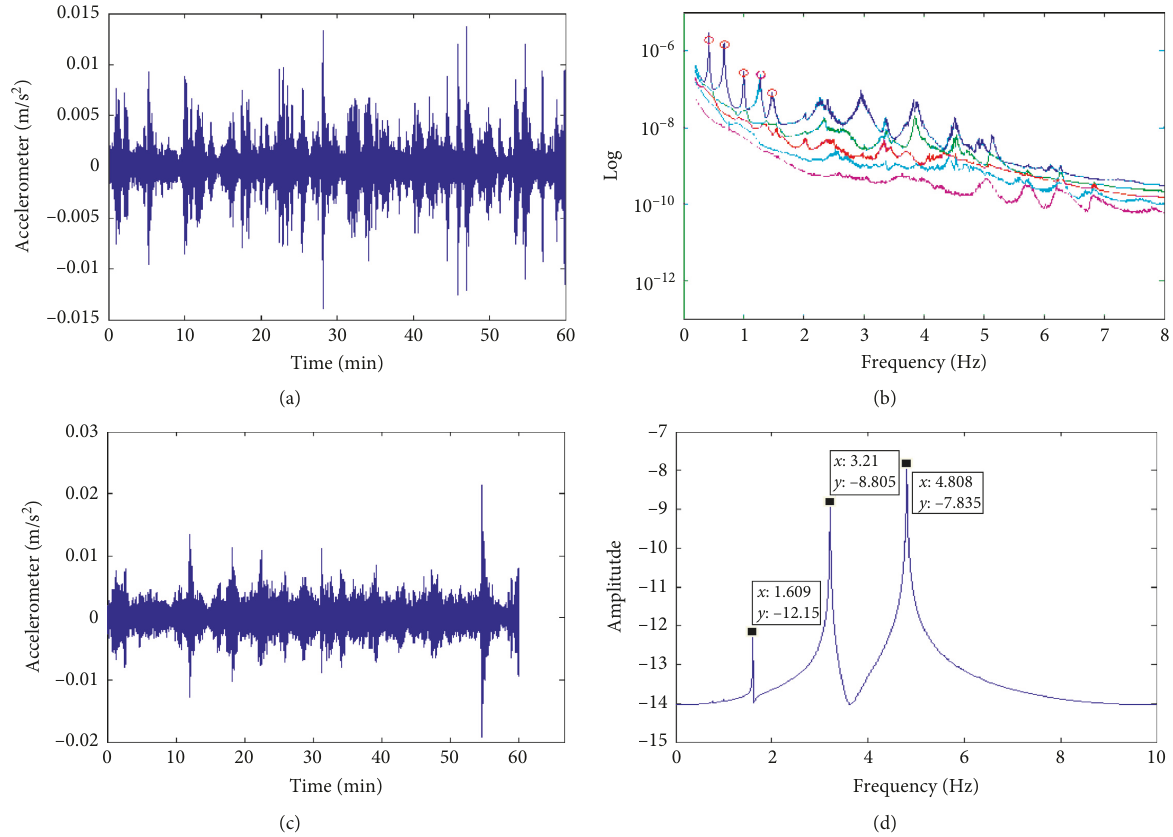
Figure 5: Ambient vibration test. (a) Acceleration time history at 1/4 section of the main girder. (b) CMIF. (c) Acceleration time history of the sling. (d) Acceleration power spectrum of the